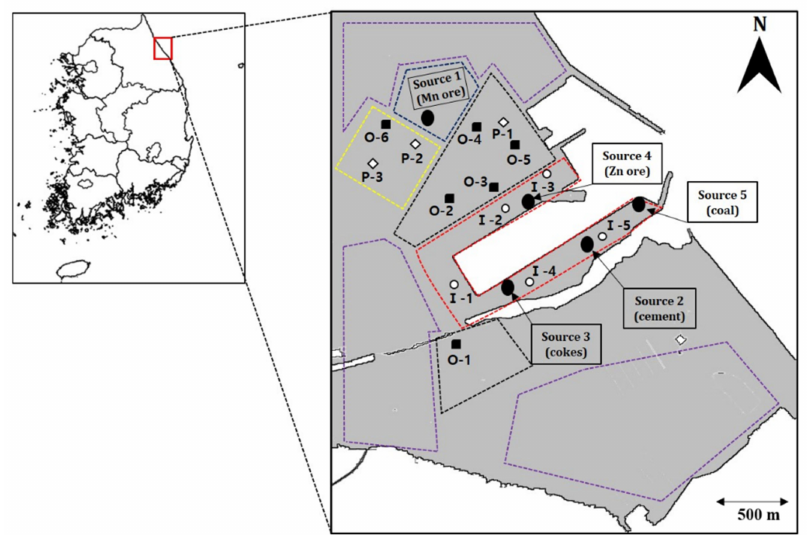
Figure 1. Map showing the location of the sampling sites in Donghae port,